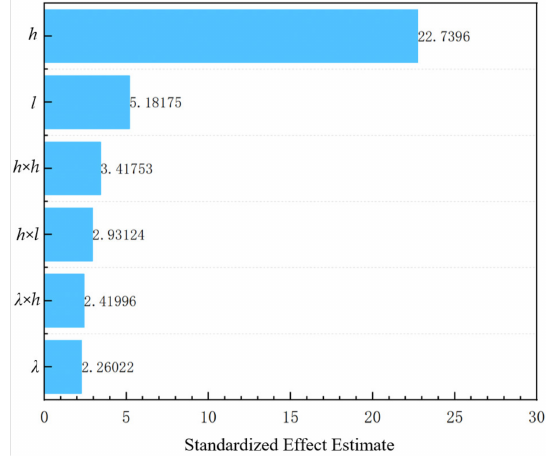
Figure 16. Pareto chart of standardized factor effects.